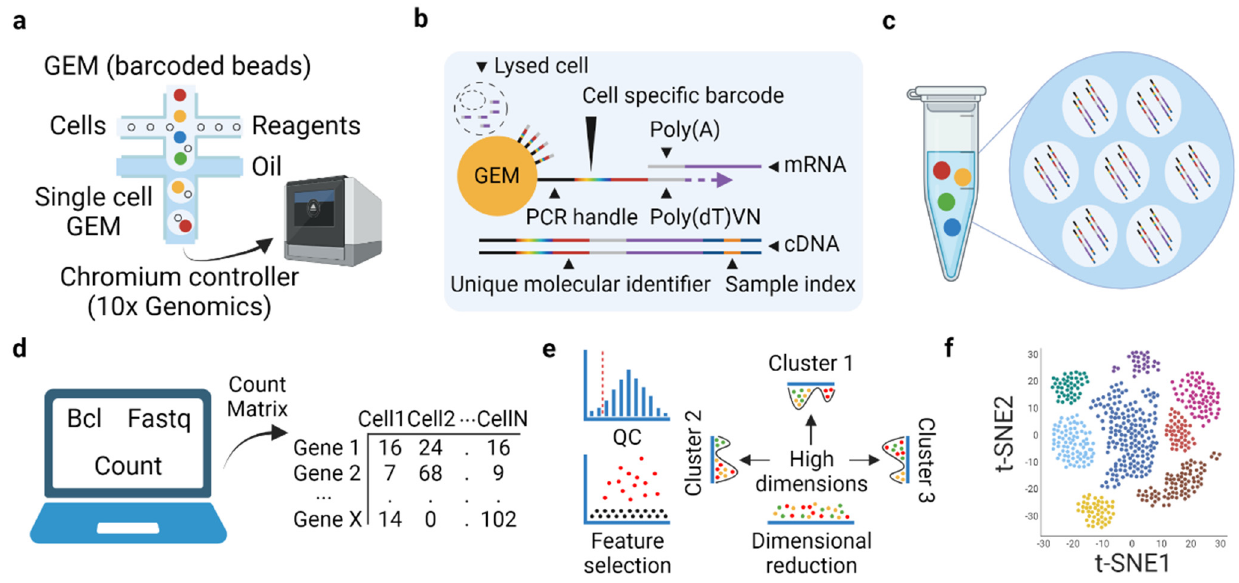
Figure 1. Scheme of droplet-based scRNAseq and standard bioinformatics pipeline. ( a ) Single cells are loaded to a microfluidic system and encapsulated to an oil droplet to generate single-cell GEM. ( b ) RNA released from the lysed single-cell is captured by barcoded oligonucleotides and reverse transcribed to the first and second strands of DNA. ( c ) PCR amplifying process is conducted to generate cDNA library, which is sequenced by Illumina sequencer. ( d ) Cell Ranger from 10× Genomics provides raw data pre-processing pipeline, resulting in the generation of a gene expression matrix. ( e ) Standard pre-processing steps for scRNAseq data. Low-quality cells are removed. Highly variable features are selected and used for principal component analysis. A high-dimensional molecular profile for individual cells is computationally classified into distinct cell populations. ( f ) Individual cells are visualized by non-linear dimensionality reduction techniques, such as t-SNE. Abbreviation: GEM; Gel Beads-In Emulsions, t-SNE; t-distributed stochastic neighbor embedding, cDNA; complementary DNA.